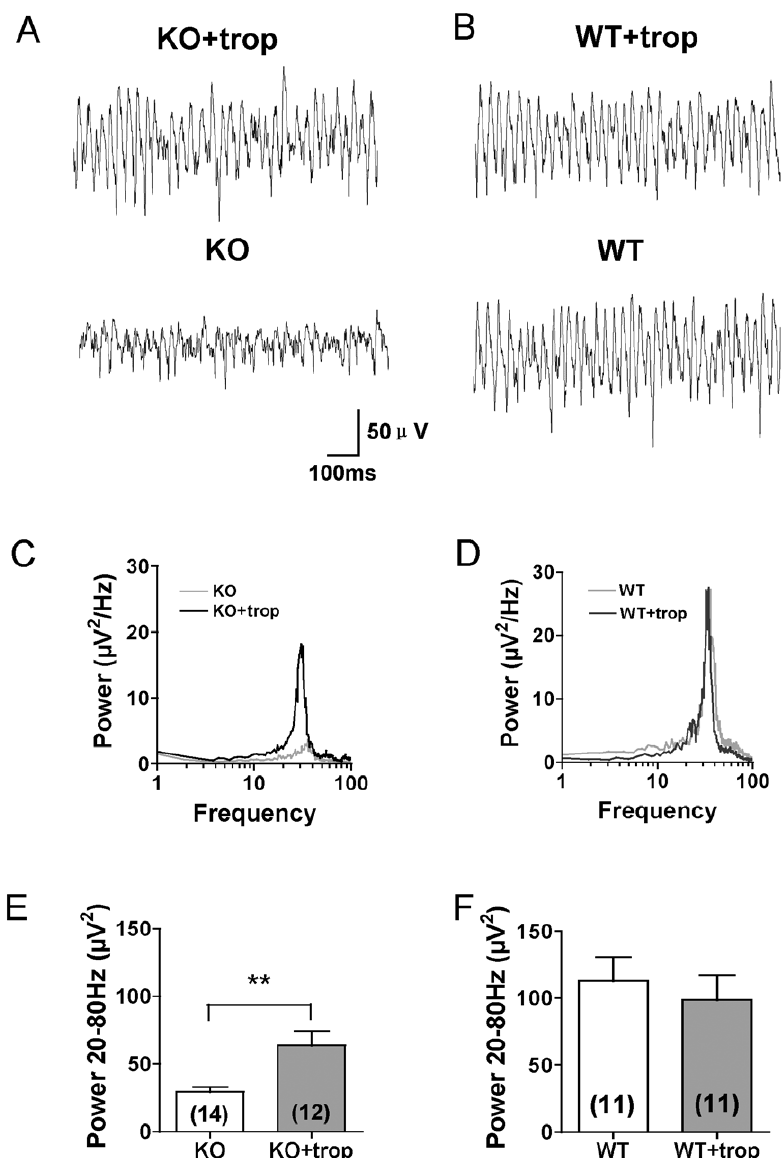
Figure 4. Reduction of gamma oscillation power in KO mice is partially reversed by 5-HT3 receptor antagonist tropisetron. A–B. Upper: Example traces of field oscillations in hippocampal area CA1 induced by carbachol in the presence of 30 nM tropisetron in slices from KO (KO + trop) (A) and WT (WT + trop) mice (B). Lower: Traces of oscillations obtained in the absence of tropisetron, are shown for comparison. C–D. Power spectra for oscillations in A (C) and B (D). E–F. Pooled data for integral oscillation power (20–80 Hz) in area CA1 in the presence of tropisetron (grey bars); data from Fig. 1 obtained in the absence of tropisetron are shown for comparison (white bars). Number of cells recorded from is indicated in parenthesis. **p , 0.01. Data represent mean 6